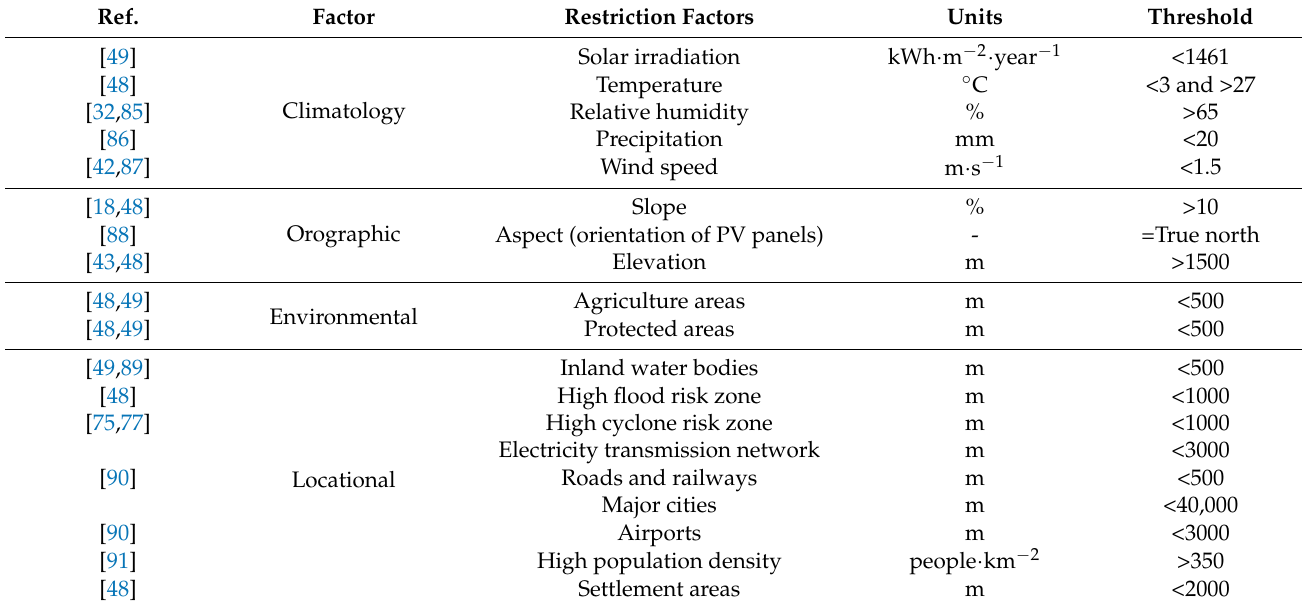
Table 5. Buffer zones and threshold values used in the spatial analysis for off-grid solar PV micro- grid